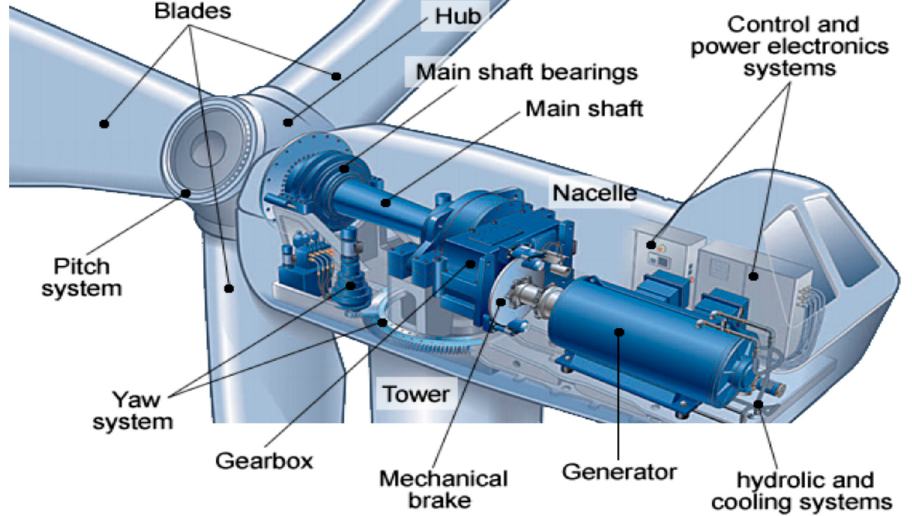
Figure 2. Typical utility-scale wind turbine main components [9].